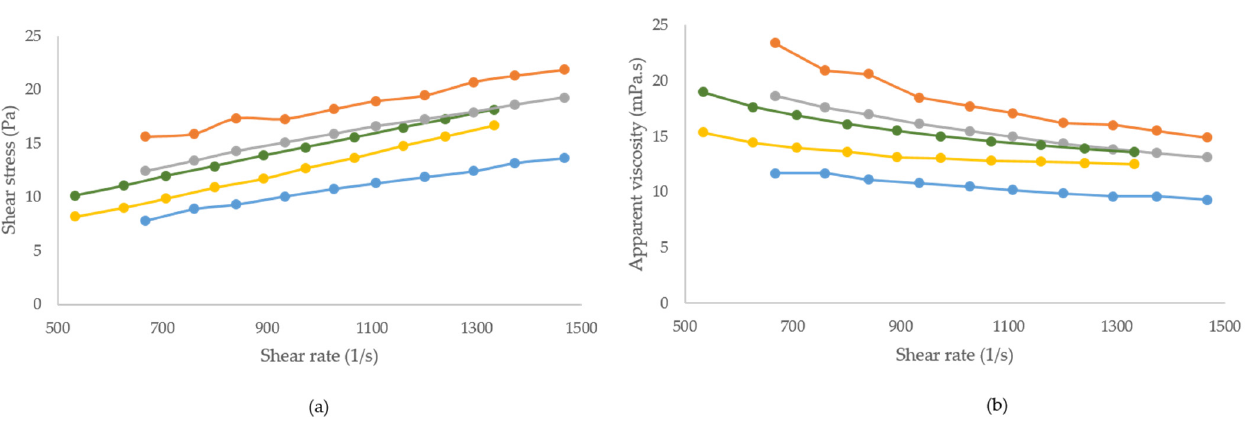
Figure 1. Uncoated mushroom slices’ oil capture kinetics during frying at 170 °C. Whole mush- room slice; mushroom stem; mushroom cap. Table 4. Rheological characteristics of the different edible coating solutions fitted to the Power Law model.